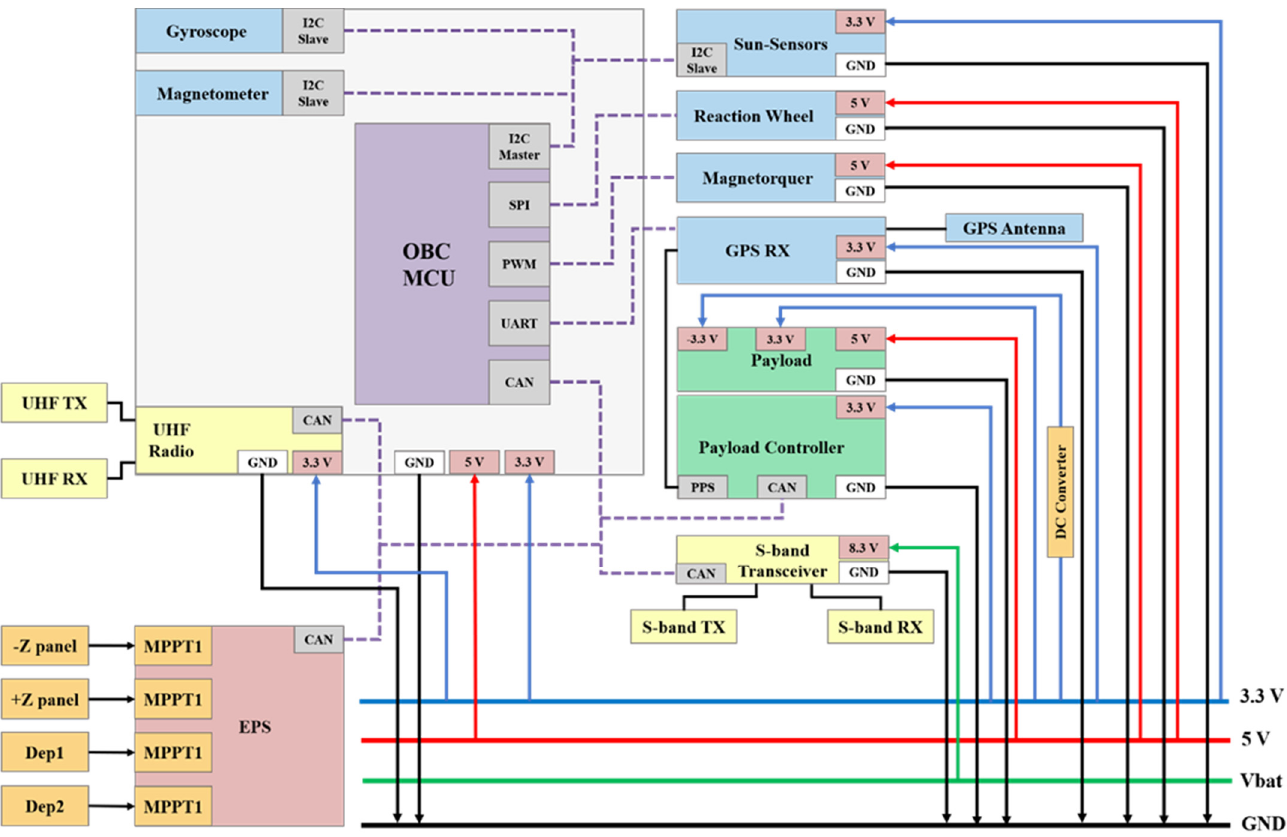
Figure 3. System architecture of Light-1.